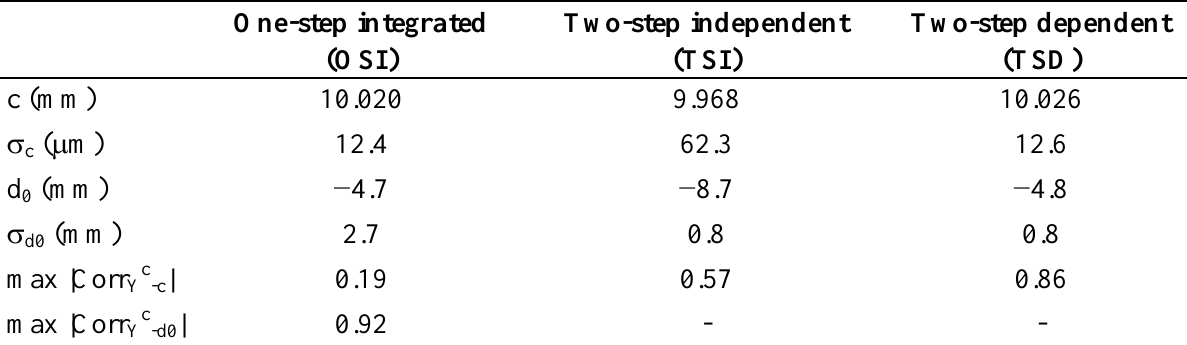
Table 6. Selected SR4000 adjustment